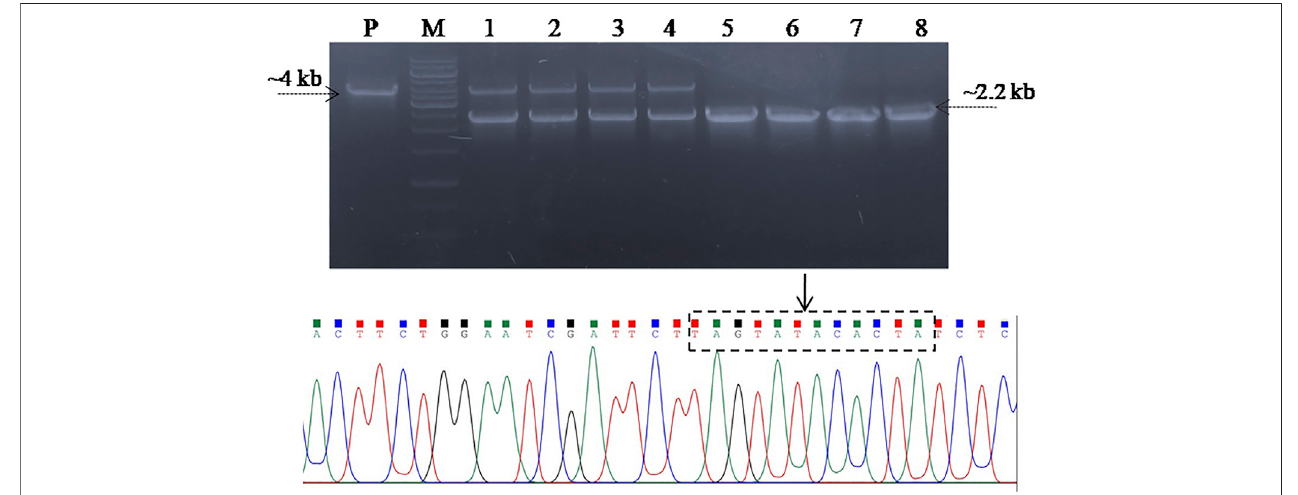
FIGURE 5 | Screening SG18 cells for SpvB gene deletion. The cells were primarily electroporated with the pET_HAs vector and after con fi rmation, subsequently; the DNA editing template-carrying cells were electroporated with pCas9_g vector. PCR-based screening showed that almost 50% cells screened showed a complete deletion of the SpvB gene, while the rest showed a partial deletion as shown in the aforementioned fi gure. The deleted mutant further con fi rmed through Sanger sequencing showed successful deletion of the SpvB gene from the large virulent plasmid of S. gallinarum , as shown in the aforementioned chromatogram. The encircled area (denoted by arrow) showing fused homology arms1 and 2 with no SpvB gene.